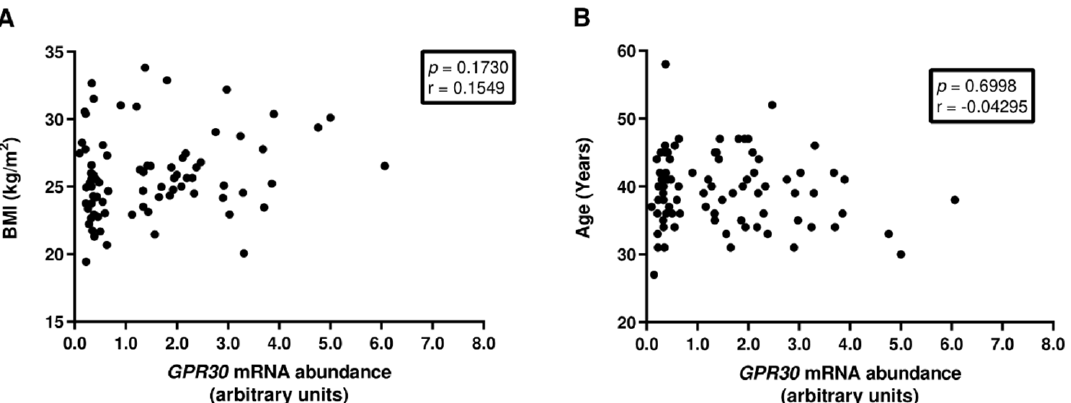
Figure 2. Association of GPR30 mRNA expression with paternal body mass index and age. The figure shows the distribution of GPR30 mRNA abundance in spermatozoa according to paternal BMI, (range 19.4–33.8 kg/m 2 ), n = 79 ( A ); and age, (range 27–58 years), n = 81 ( B ). The association between GPR30 mRNA abundance, paternal BMI, and age was evaluated by computing the Pearson correlation coefficients (r), assuming a Gaussian distribution (confidence interval of 95%). No correlations between the studied parameters were found to be statistically significant.